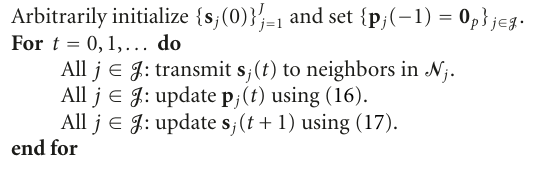
Algorithm 2: D-LMS with Ideal